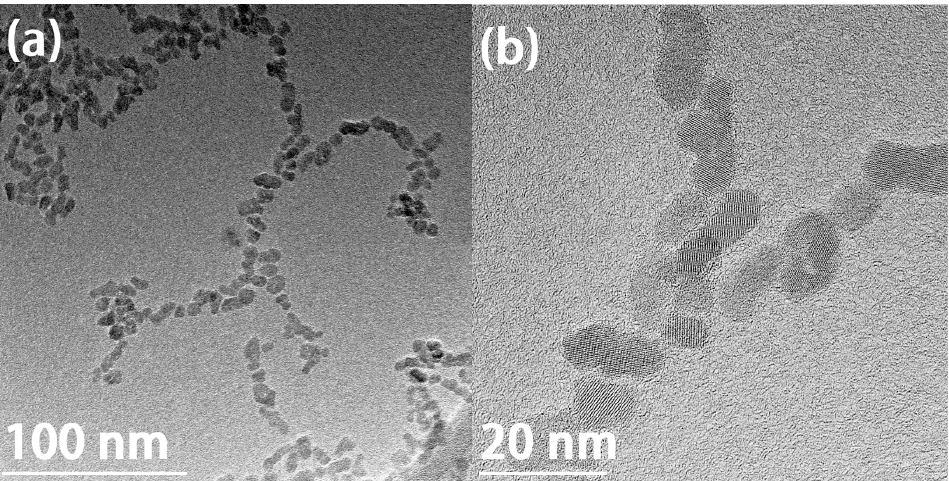
Figure 7. TEM micrographs of hematite nanoparticle sample with 0.75 mM NaH 2 PO 4 . ( a ) Image of aggregated of hematite particles; ( b ) High-resolution image of aggregated particles.